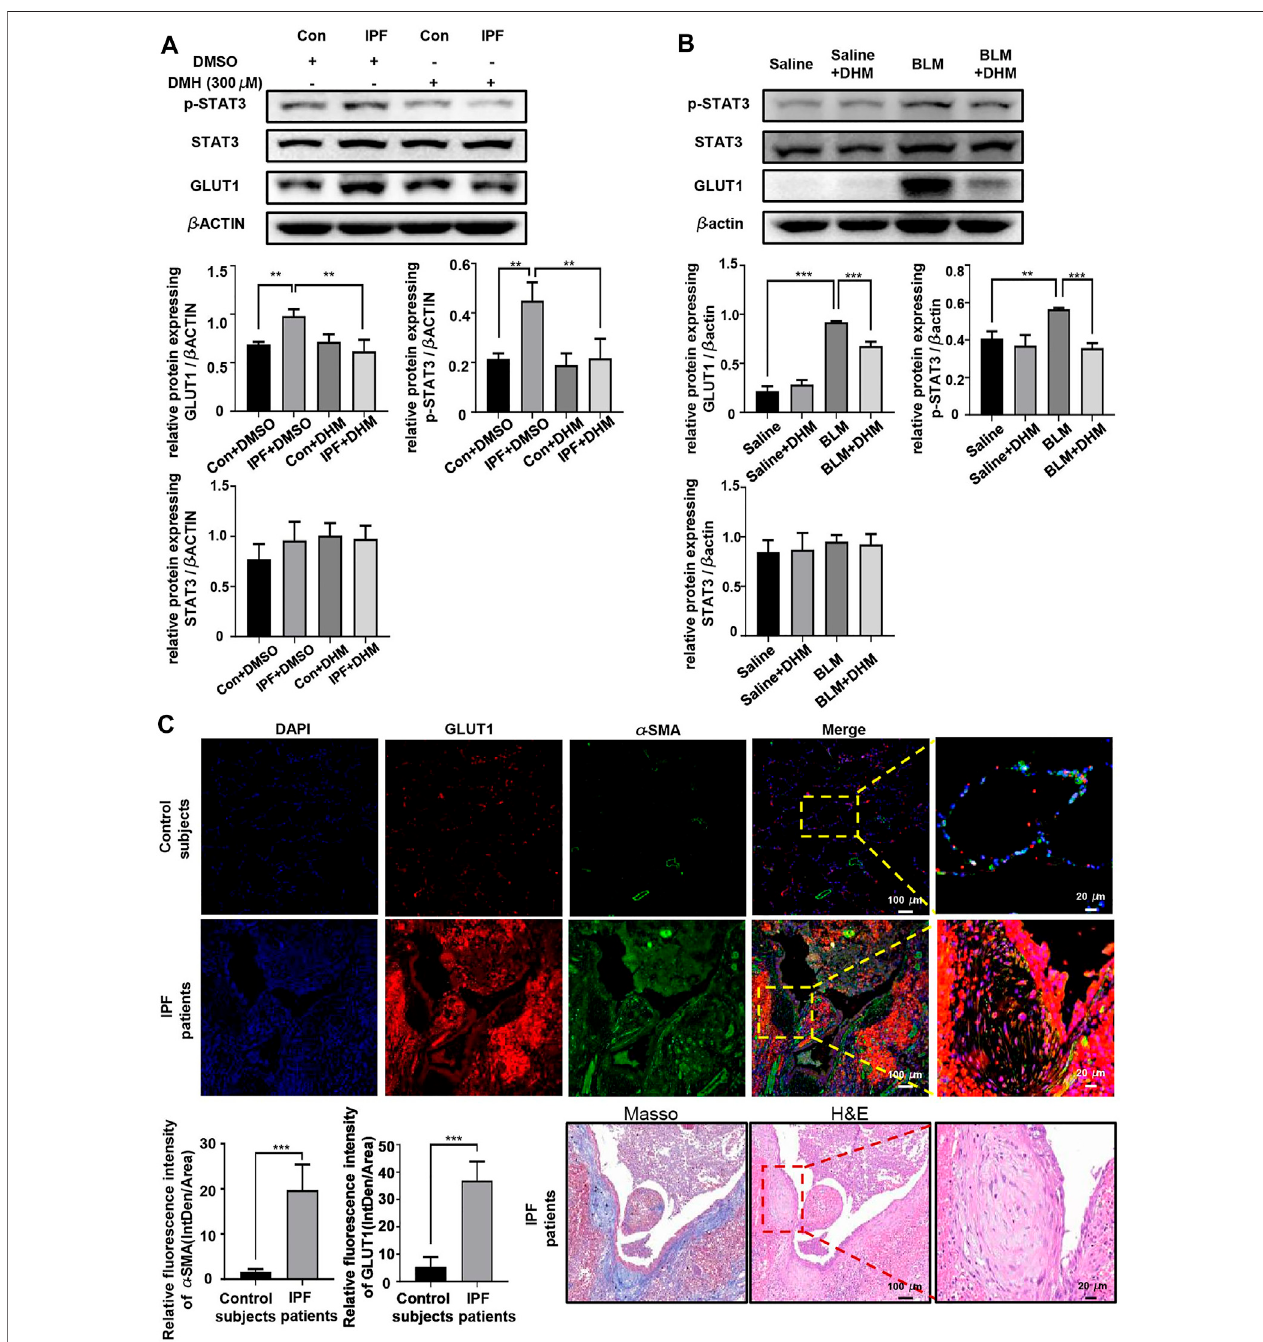
FIGURE6 | DHM affects the expression ofpSTAT3/GLUT1. (A) Westernblottinganalysisof the levels of STAT3/p-STAT3/GLUT1 in PHLFs treated with DHM ( n = 5). (B) Western blotting analysis of the levels of STAT3/p-STAT3/GLUT1 in the DHM-treated mouse model ( n = 5). (C) Representative images for coimmunostaining of GLUT1 and α -SMA in the lung sections from control subjects and IPF patients. Images were captured at 100 × and 400 × magni fi cation (control subjects = 5, IPF = 8). RepresentativeimagesforMassonandH&EstainofanIPFpatient.Thedataarerepresented asthemean±SD.Ordinaryone-wayANOVAanalysiswasapplied.*, p < 0.05; **, p < 0.01; ***, p <